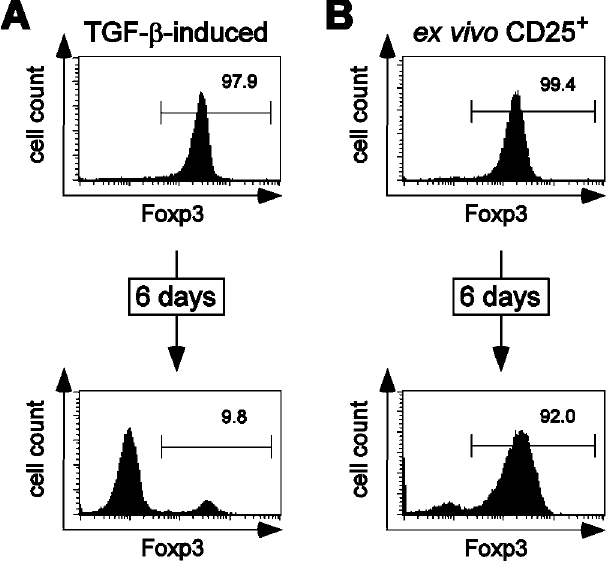
Figure 7. TGF- b –Induced Foxp3 þ Tregs Loose Foxp3 Expression upon Restimulation (A) CD25 (cid:1) CD4 þ T cells were cultured for 6 d in the presence of TGF- b as described in Figure 6. On day 6, cultured cells were sorted by FACS for CD25 þ cells and analyzed for intracellular Foxp3 expression by FACS (upper panel). Sorted CD25 þ cells from the same TGF- b -cultures were restimulated for another 6 d in the absence of TGF- b . On day 6, cultured cells were analyzed for intracellular Foxp3 expression by FACS (lower panel). Numbers display frequency of cells within indicated populations. (B) Ex vivo isolated CD25 þ CD4 þ Tregs were analyzed for intracellular Foxp3 expression before (upper panel) and after 6 d in vitro culture (lower panel) by FACS. Numbers display frequency of cells within indicated populations. One representative experiment out of two individual experiments is